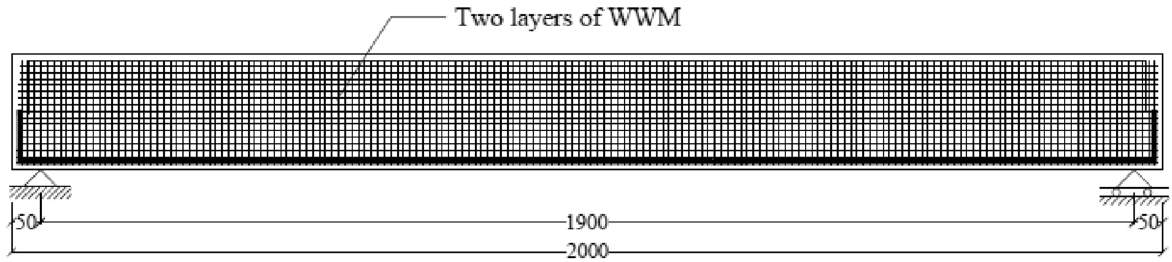
Fig. 9 Longitudinal cross section of FC beams, dim in mm